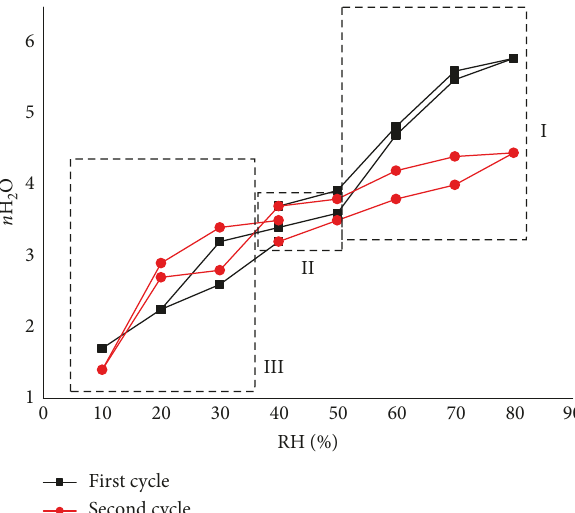
Figure 7: Development of the interlayer water contents as function of the RH% along the first and the second cycles in the case of SWy-2-Mg complex.